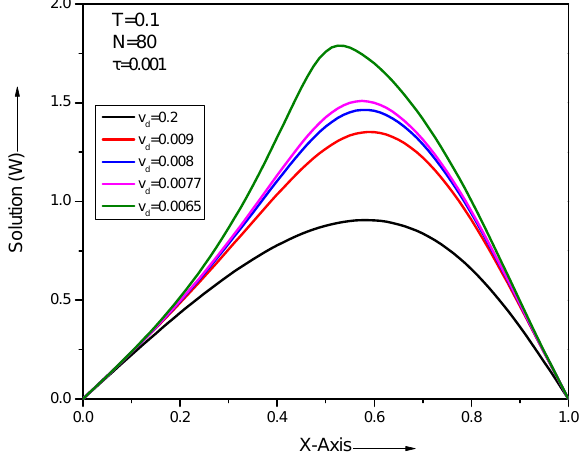
Figure 4. Comparison of analytical and numerical results for problem 5.1 at time T = 10, ν d = 0.001, τ = 0.001 and ∆ x = 0.0125.